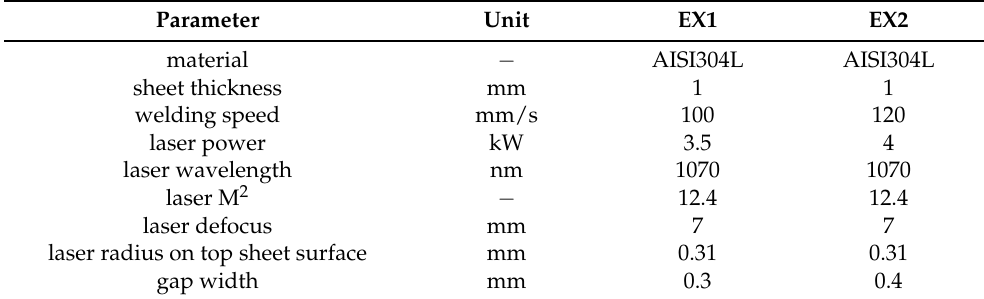
Table 1. Conditions of the laser beam welding (LBW) experiments EX1 and EX2 used for model calibration and validation.